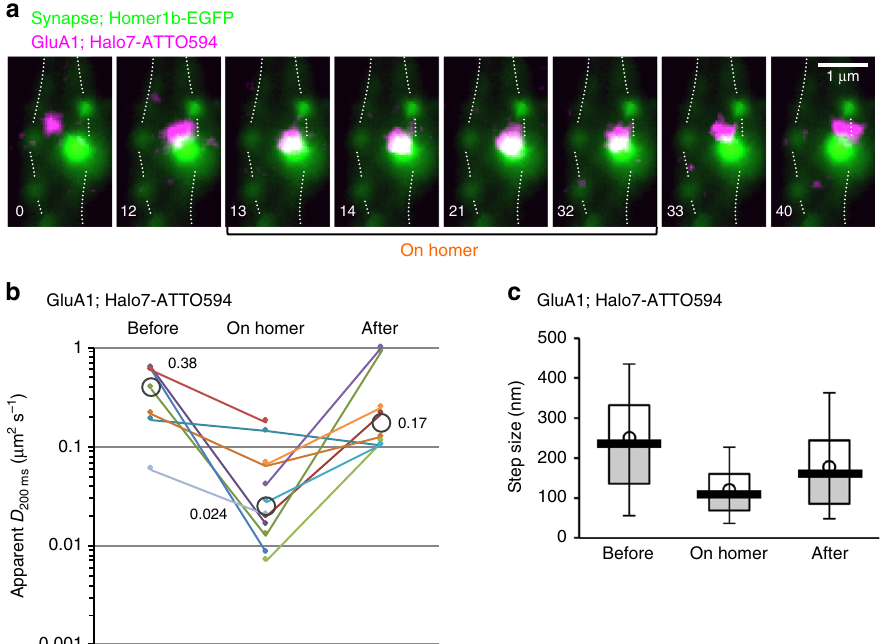
Fig. 8 Fast diffusing GluA1 monomers and dimers enter and exit from the synaptic region. a A typical image sequence of a fl uorescent spot of Halo7-GluA1 (labeled with ATTO594; magenta spot; representative results from 13 independent video clips), entering a synaptic region (marked by Homer1b-EGFP, green spot) from the dendritic-shaft PM and exiting from the synaptic region into the dendritic-shaft PM in cultured mouse hippocampal neurons (13 DIV). Dotted lines indicate the peripheries of the dendritic shaft. b The changes of apparent D 200ms for each fl uorescent Halo7-GluA1 spot when it entered and/ or exited from the synaptic region marked by Homer1b-EGFP (shown by small closed circles; median values are shown by larger gray open circles). The apparent D 200ms for each fl uorescent spot was simply evaluated from the increment of the MSD during 200 ms, due to the limited signal-to-noise ratios for observing single molecules in the synaptic region. (Before) In the dendritic-shaft PM right before entering the synaptic region. (On Homer) During the period in the synaptic region. (After) In the dendritic-shaft PM right after exiting from the synaptic region. Lines (and closed small circles with the same color) indicate the same fl uorescent spots. c The changes of the step sizes of Halo7-GluA1 spots when they entered and/or exited from the synaptic region. Bars, circles, boxes, and whiskers indicate the median values, mean values, interquartile range (25 – 75%), and 10 – 90% range,